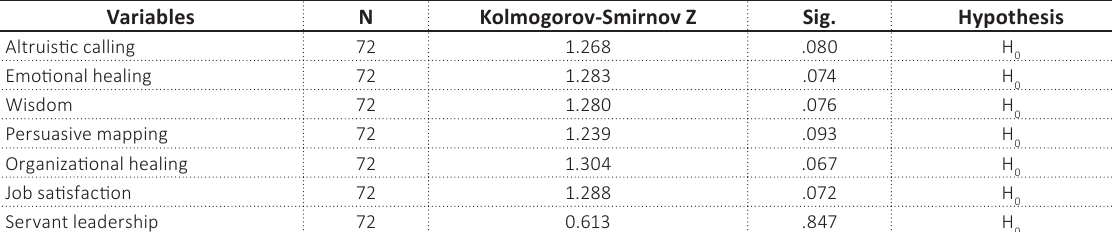
Table 2. Descriptive statistics of research